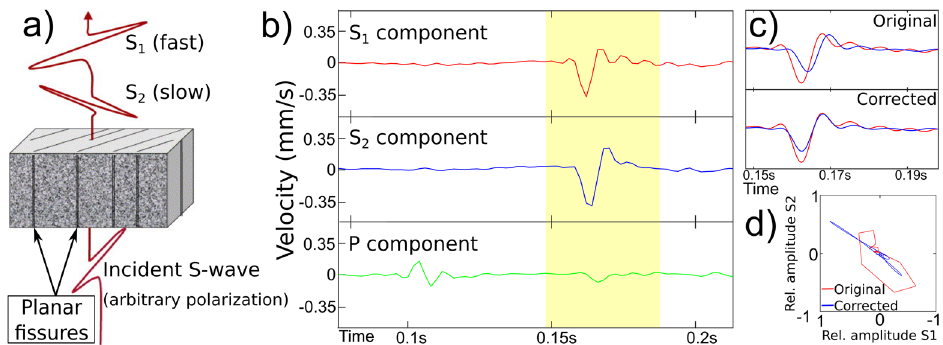
Fig. 2 Shear wave splitting mechanism with an example from icequake data. a Principle of fracture-induced shear wave splitting (SWS), adopted after Rial et al. 20 . b An example of a Rhonegletscher stick-slip icequake seismogram in ray-frame coordinates, the highlighted area indicates the S-phase presented in ( c , d ). c Time delay between two S-wave phases before and after SWS correction. d Relative amplitude of pre and post-correction particle motion of signals shown in (